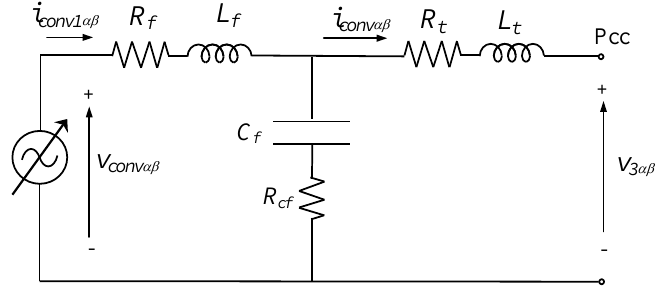
Figure 1. ACISEF equivalent circuit with an output LC filter. Figure 18. ACISEF equivalent circuit with an output LC